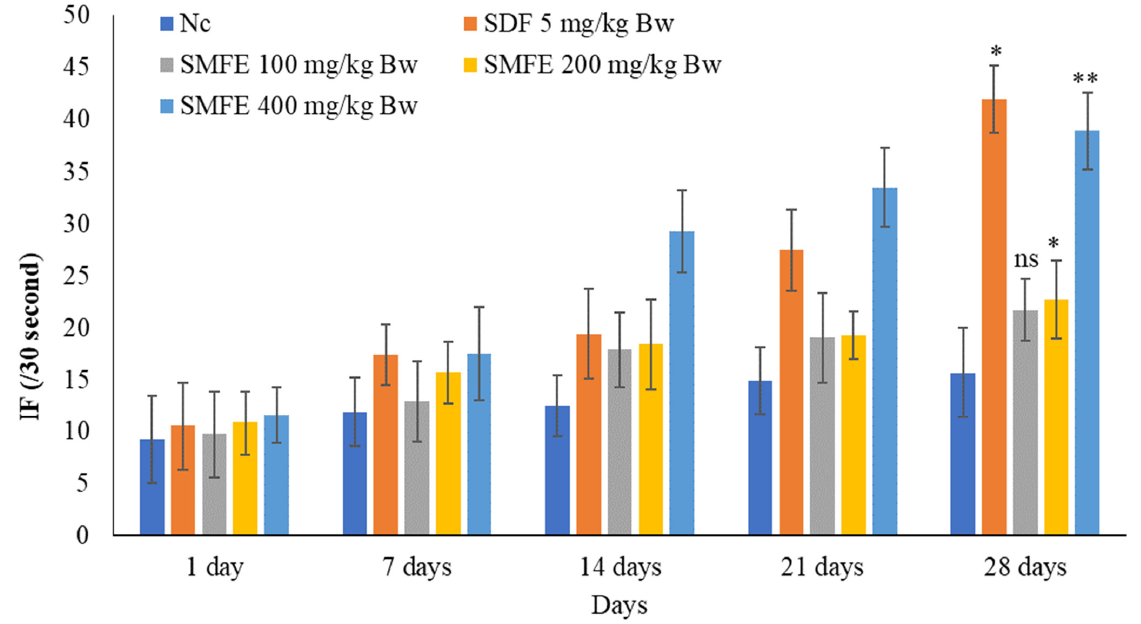
Figure 6. Effect of S. mangifera fruit extract on intromission frequency ( n = 6). The values are means ± SEM; * p < 0.05, ** p < 0.1; ns p > 0.05 (followed by Student Dunnett test).